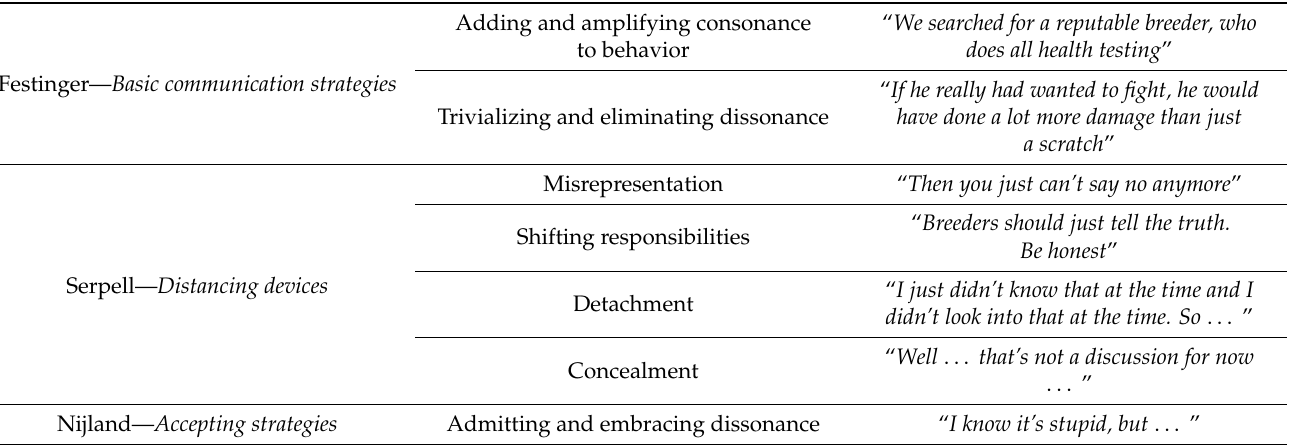
Table 3. Framework for categorizing coping strategies based on Festinger [35], Serpell [36], and Nijland [31].